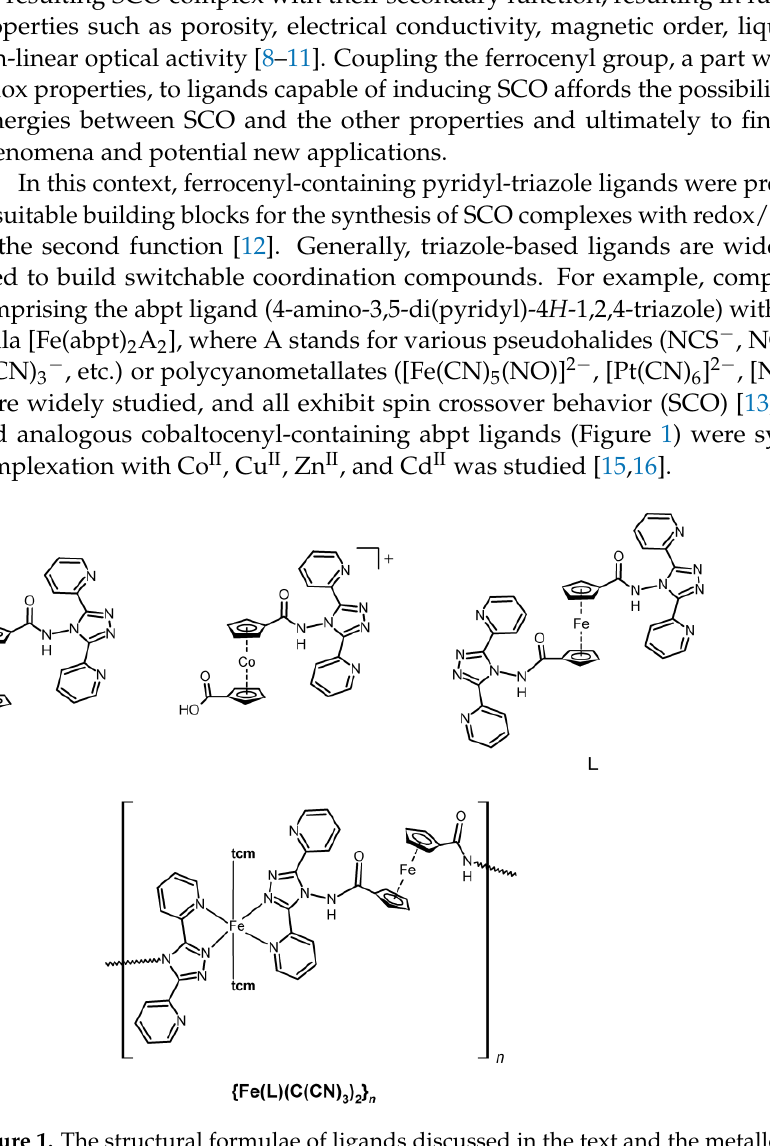
Figure 1. The structural formulae of ligands discussed in the text and the metalloligand L studied herein ( top ). The proposed structural formula of polymeric Fe II complex 1 (tcm = tricyanomethanide anion) ( bottom ).